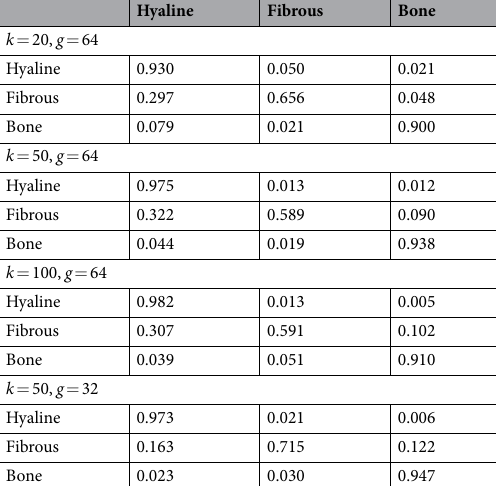
Hyaline Fibrous Bone k = 20, g = 64